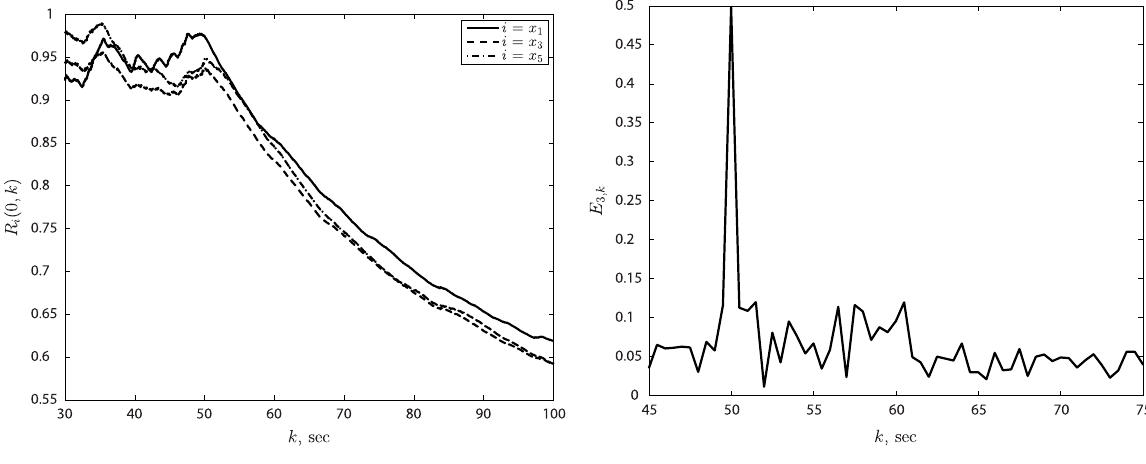
Fig. 7. Time-dependent variance of various floor measurements. Fig. 8. Variation of E 3 ,k in x 3 ( t )